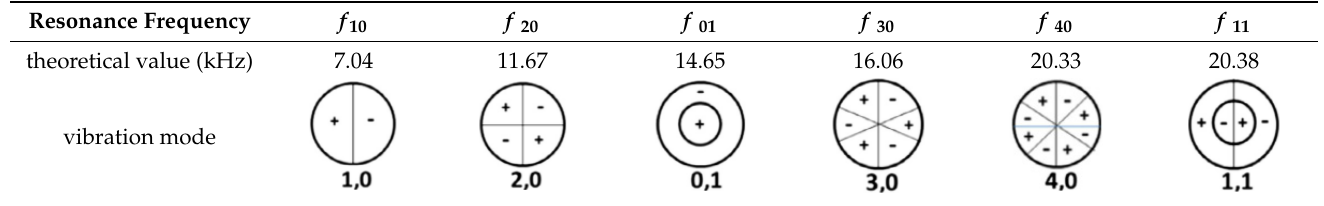
Table 4. The calculated value of resonance frequency at the temperature of 2500 K.